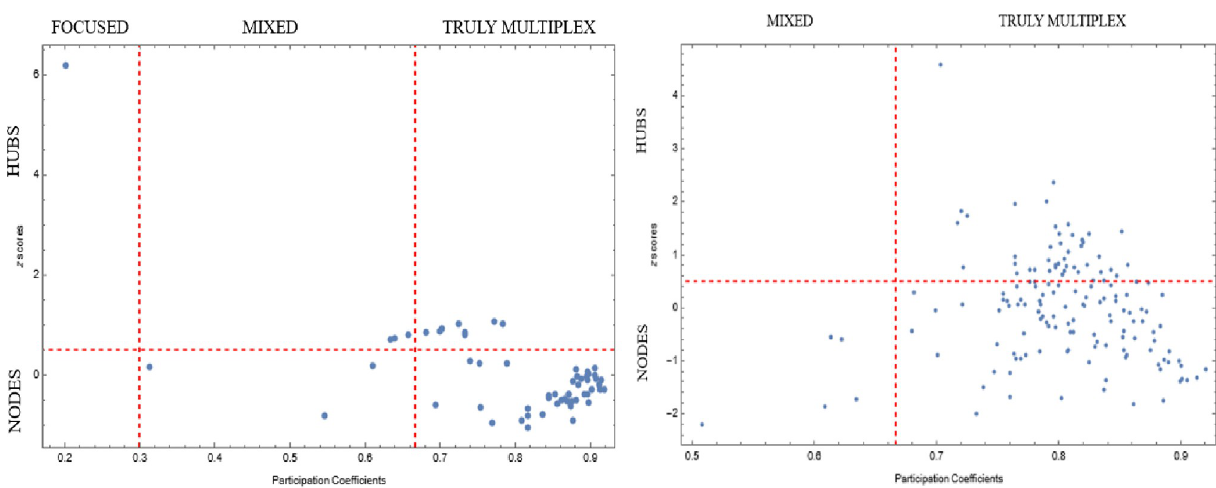
Fig 3. Plotting the multiplex participation coefficient P ( i ) with the Z -score of total overlapping strength yields a map of the responsibilities of nodes in a multilayer network for Central and Eastern Europe regions (left hand side) and Western Europe regions (right hand side). Note : Even if two nodes have the same Z -score value, their functions might change significantly depending on the value of their multiplex participation coefficient. https://doi.org/10.1371/journal.pone.0283277.g003 As Fig 4 shows, the first row of the heat map indicates the probability of edges of the GDP layer to be present in other layers. When looking at the overall matrix, every edge from the GDP, GVAD, LU, DHI, AP and IBA layers may be found in other layers. Hence, it can be stated that these were the most effective factors. The ELET variable had the lowest efficiency